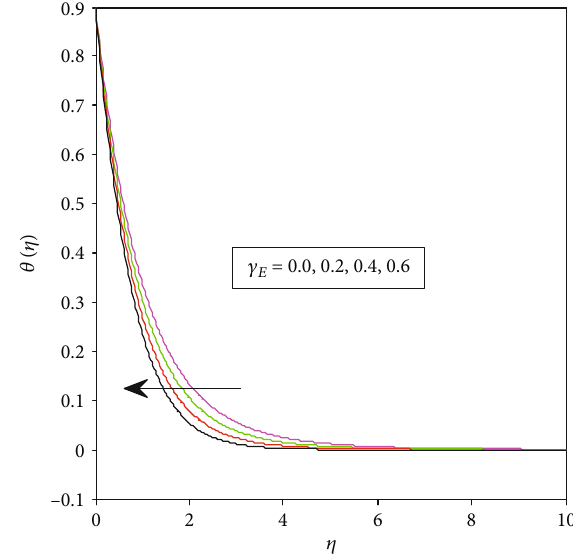
Figure 8: Temperature distribution for di ff erent values of the mixed convection parameter.